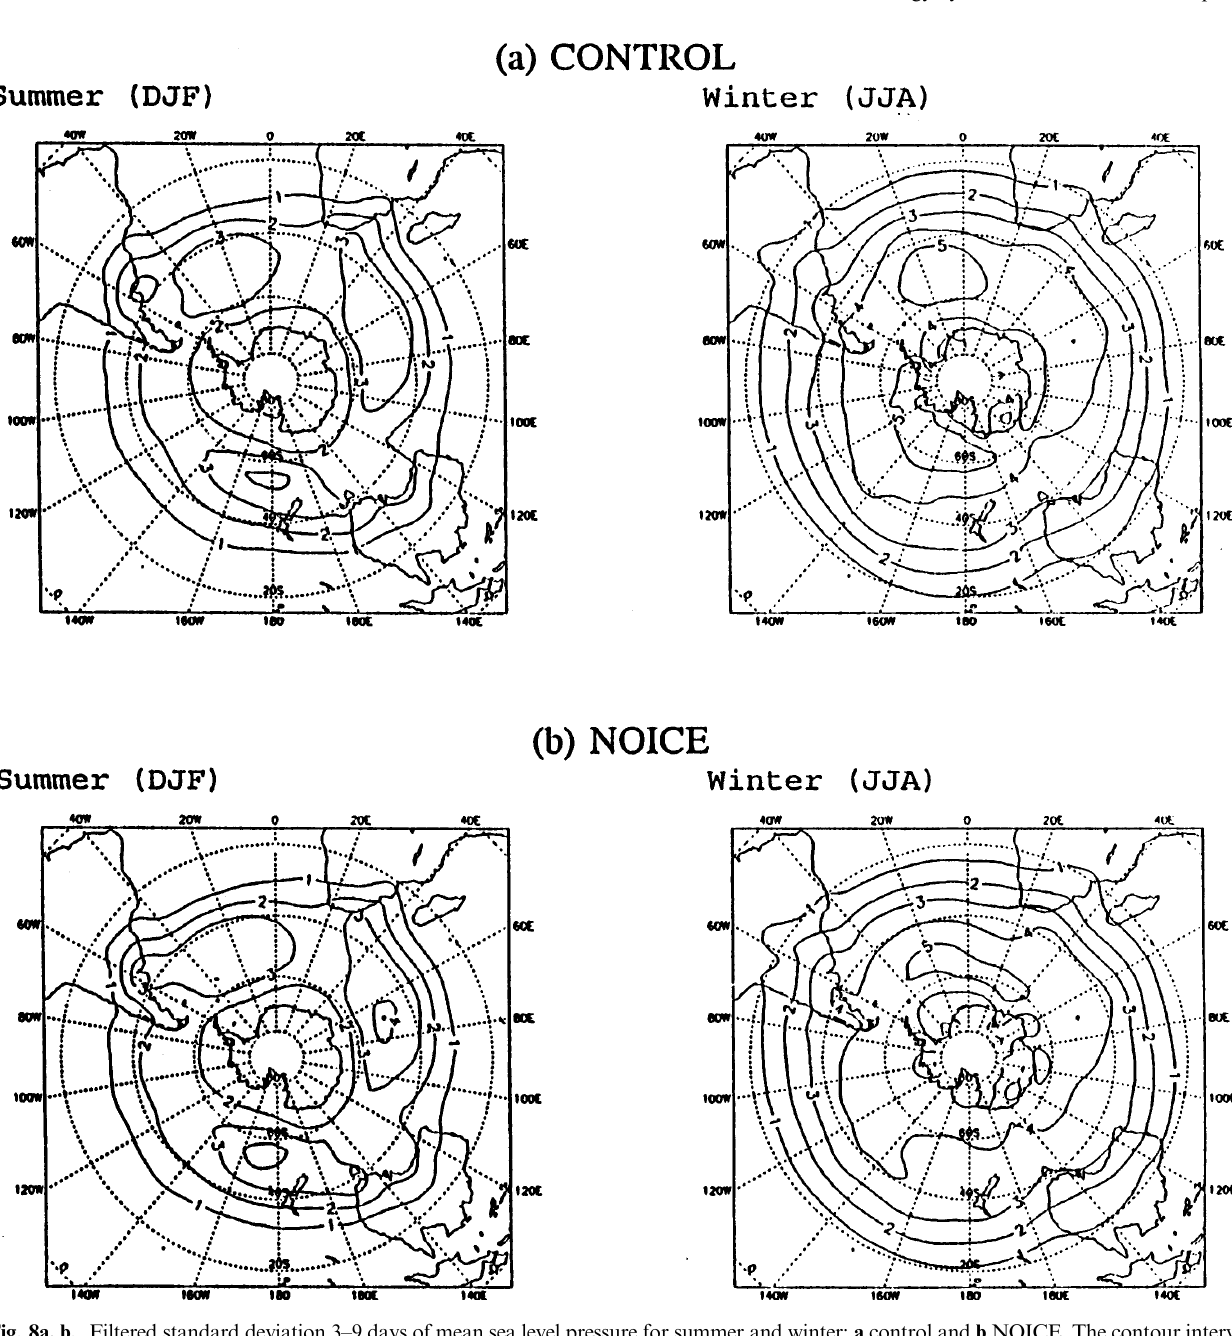
Fig. 8a, b. Filtered standard deviation 3–9 days of mean sea level pressure for summer and winter: a control and b NOICE. The contour interval is